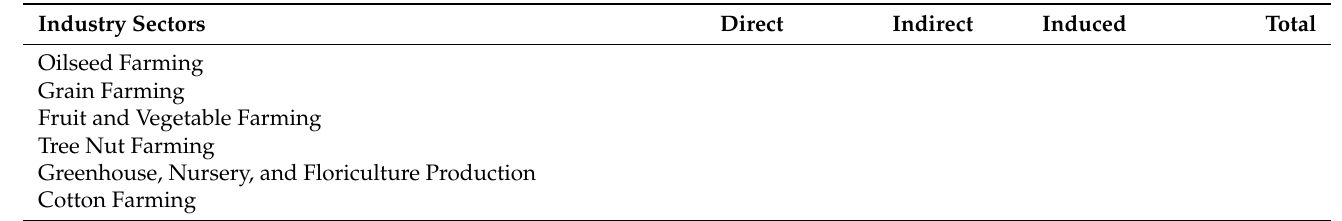
Table 6. Contribution of the water transportation to TIO by industry ($